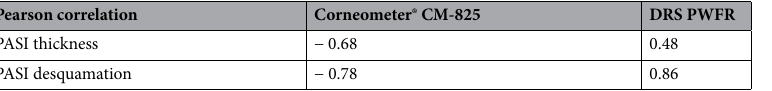
Table 2. Pearson correlation coefficients between PASI scores (thickness and desquamation) and the values deduced from Corneometer and DRS systems of 15 psoriasis vulgaris patients.